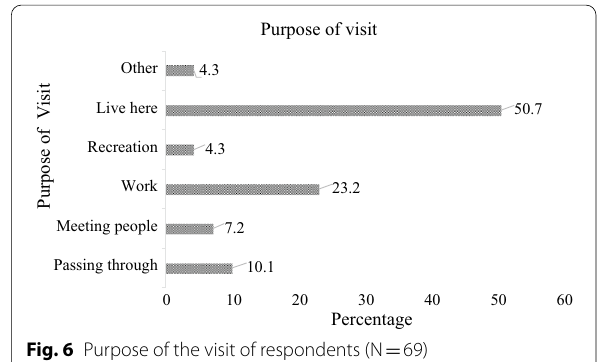
Fig. 6 Purpose of the visit of respondents (N